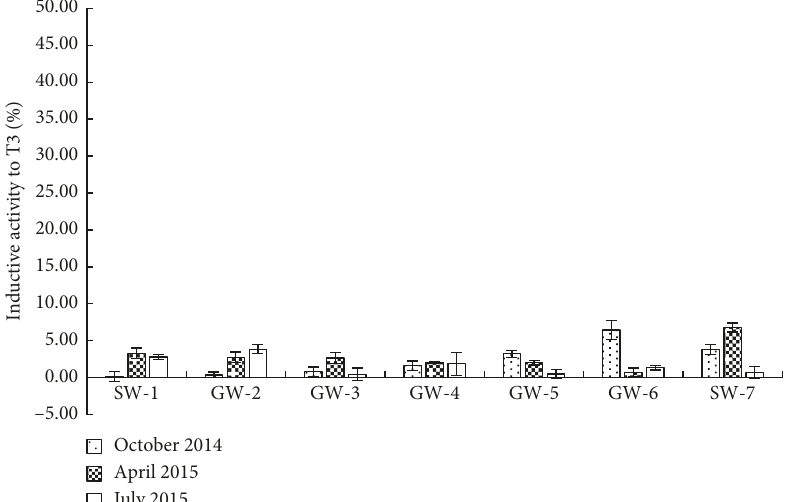
Figure 2: Induction of β -galactosidase activity by water samples using recombinant TR gene yeast assay.